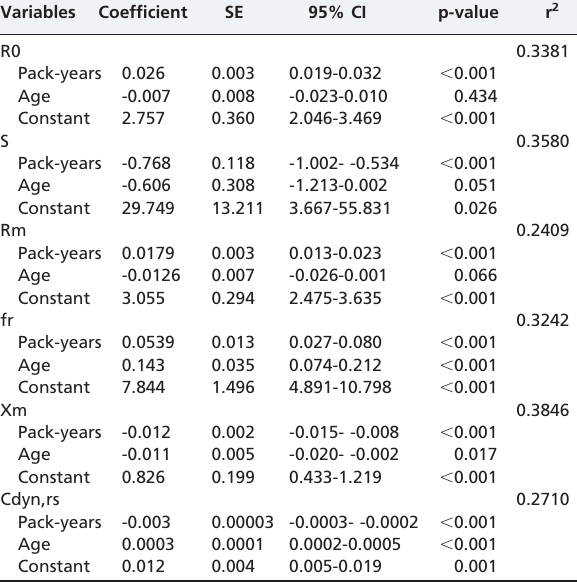
Table 3 - Predictive equations for impedance variables derived from a multiple regression analysis Variables Coefficient